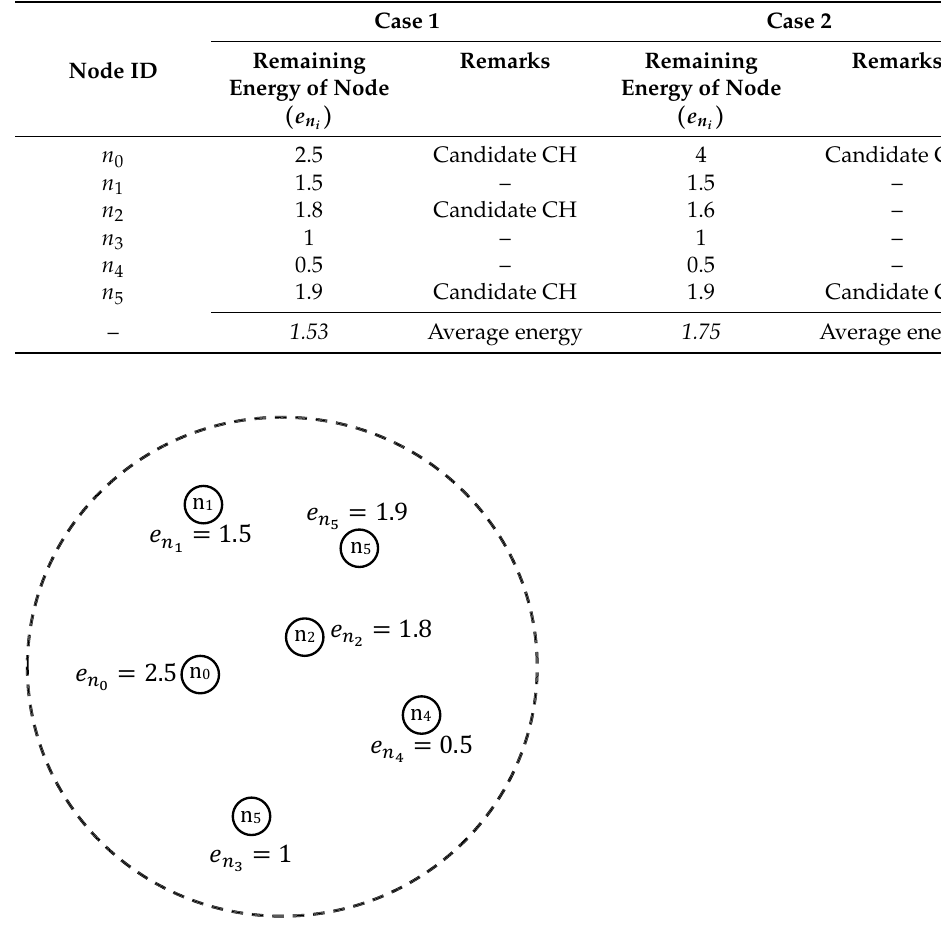
Table 1. Remaining energy of nodes in Case-1 and Case-2.